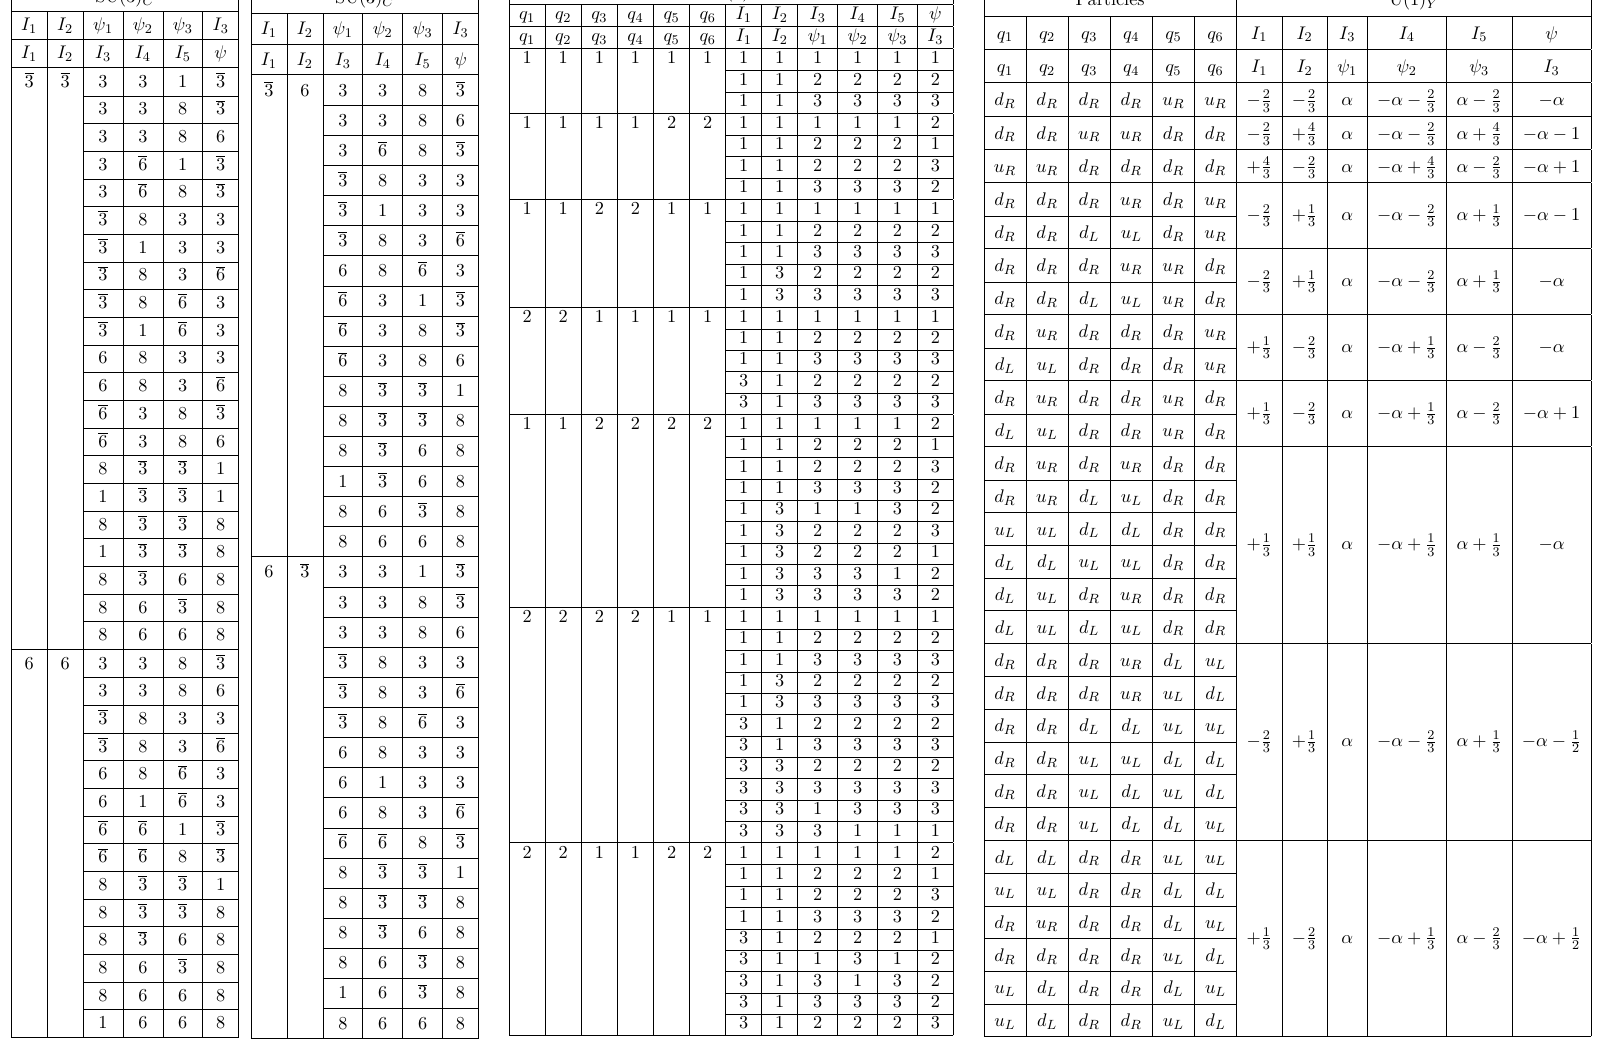
Table 5 . The possible numbers of the fields in Topology-L-2 and